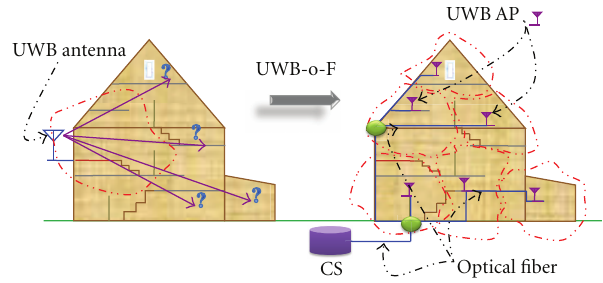
Figure 1: An UWB-o-F system for high data rate coverage (UWBAP: UWB Access